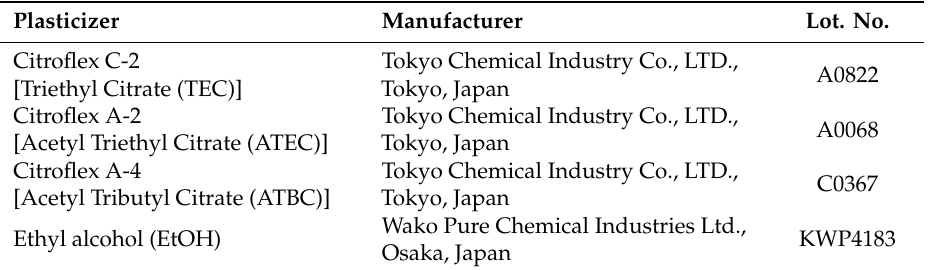
Table 2. Plasticizers used.